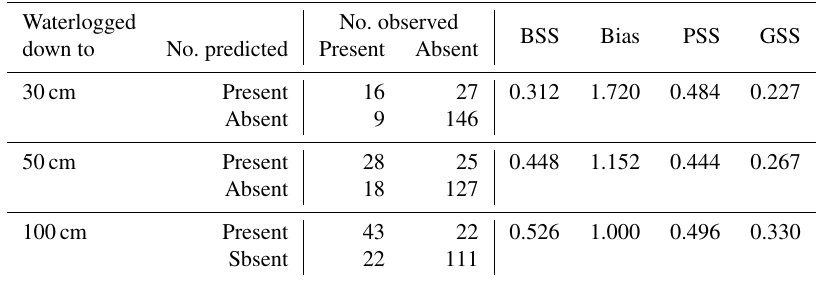
Figure 5. The geoGAM predictions of effective cation exchange capacity (ECEC) at 0–20cm of depth in the mineral soil of forests in the Canton of Zurich, Switzerland (computed on a 20m grid with final geoGAM with covariates according to Table 2. Black dots are locations used for geoGAM calibration, locations with red triangles were used for model validation and ECEC legend classes are according to Walthert et al., 2004). Table 4. Observed occurrence of waterlogged horizons at three soil depths against predictions by geoGAM for the 198 sites of the validation set. Waterlogged soil horizons were predicted to be present if prediction probabilities were larger than an optimal threshold (30cm: 0.22, 50cm: 0.35, 100cm: 0.51) found by cross-validation with Gilbert skill scores as criteria (No.: number of sites per response level, BSS: Brier skill score, bias: bias ratio, PSS: Peirce skill score, GSS: Gilbert skill